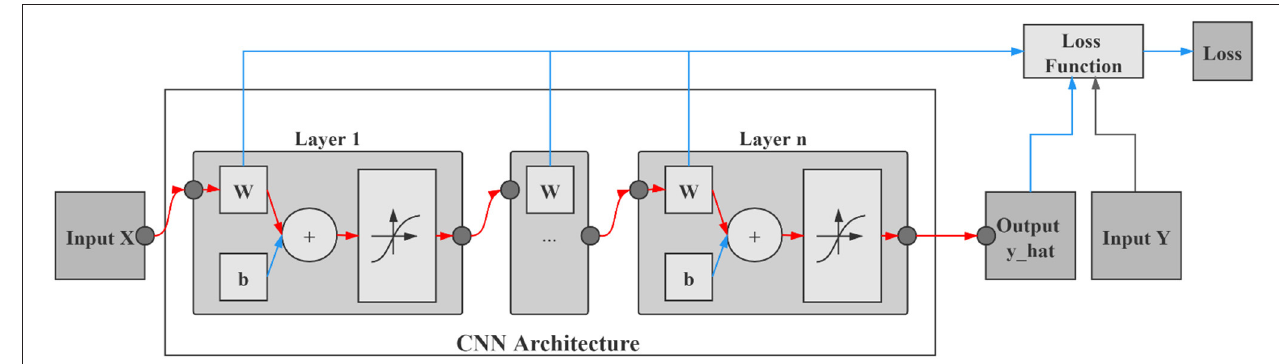
FIGURE 3 | Computational graph of the propagation of convolutional neural network (CNN).